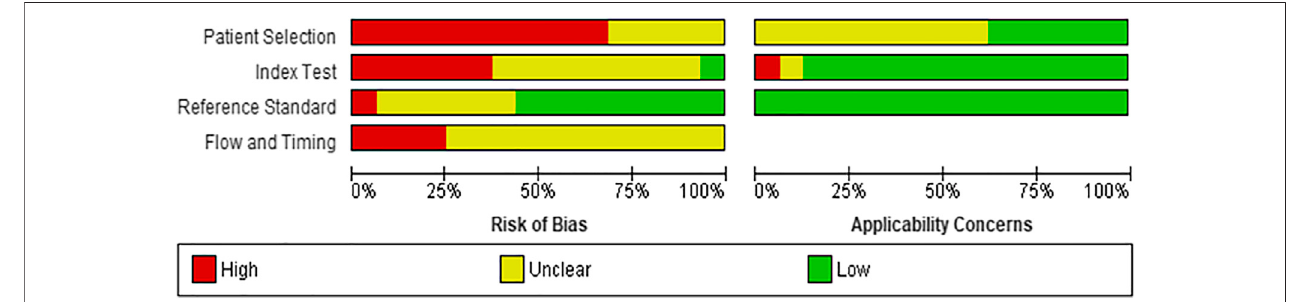
FIGURE 2 | Risk of bias assessment and applicability concerns for included